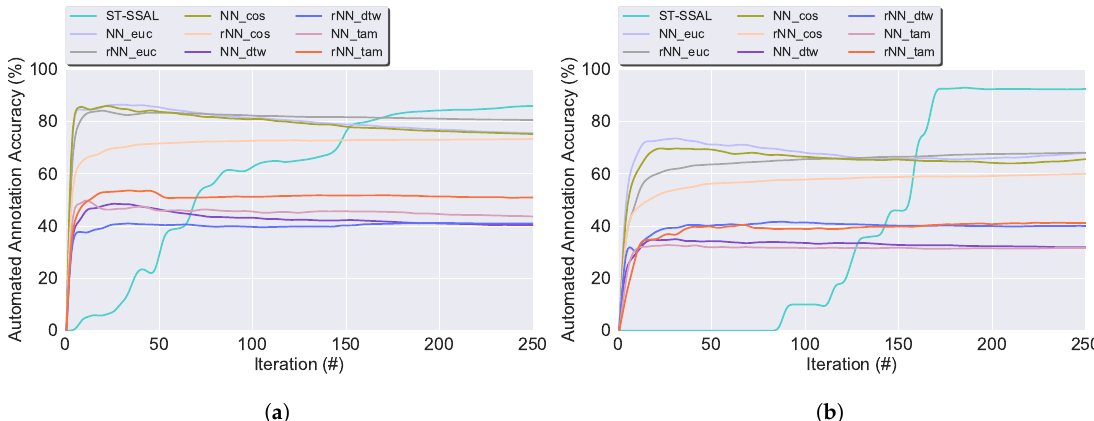
Figure 11. Percentage of correctly automatically annotated samples throughout the AL iterations, for the SSAL methods, using the UCI and the CADL datasets. Following the underscore in the NN and rNN methods: Euc, Cos, DTW and TAM, denote the similarity distances used in the respective